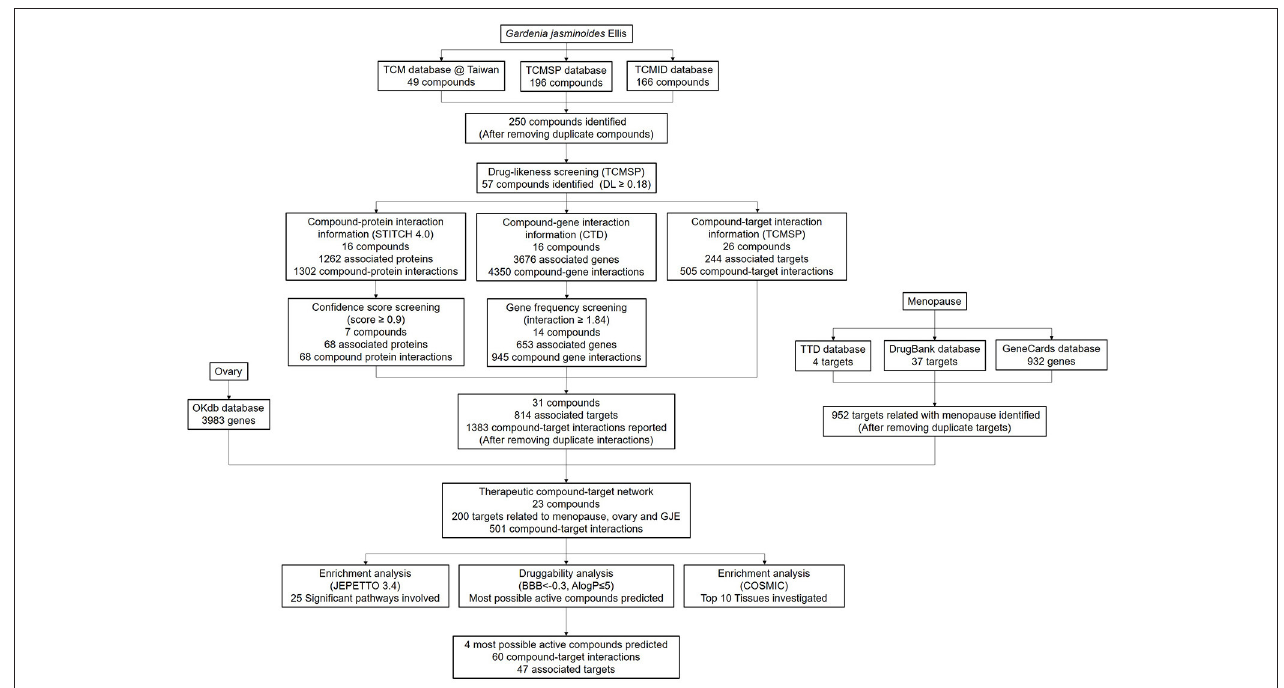
FIGURE 2 | The workflow of network pharmacology study of